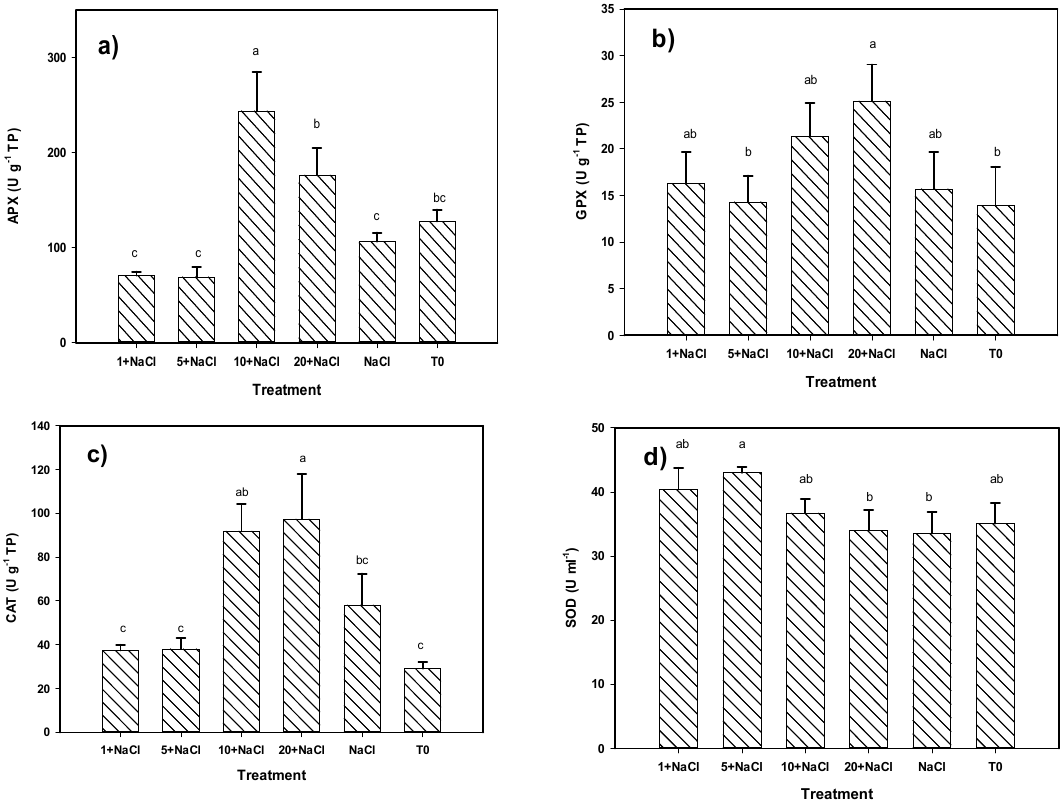
Figure 6. Enzymatic antioxidant compounds ( a ) APX, ( b ) GPX, ( c ) CAT, ( d ) SOD in tomato fruits under NaCl stress and an application of Se NPs. T0: Control. NaCl: NaCl-only treatment. The terms 1, 5, 10, and 20 + NaCl represent the amount of Se NPs applied (mg L − 1 ) plus 50 mM of NaCl. APX: Ascorbate peroxidase. GPX: Glutathione peroxidase. CAT: Catalase. SOD: Superoxide dismutase. TP: Total proteins. Di ff erent letters per bar indicate significant di ff erences according to Fisher’s least significant di ff erence test ( p < 0.05).